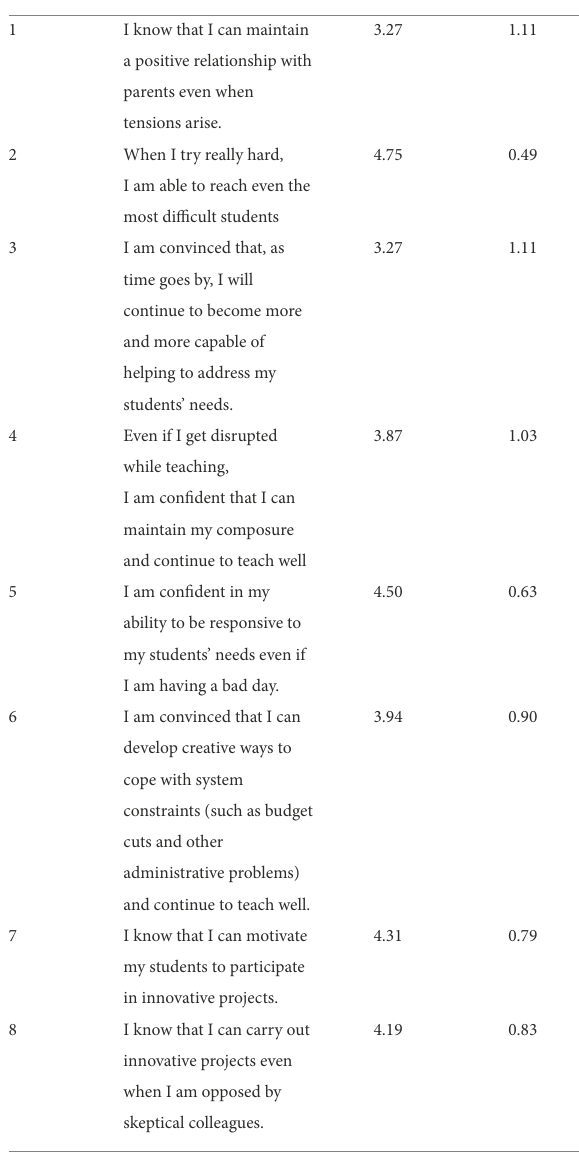
TABLE 2 Descriptive statistics for participants’ self-efficacy levels. Item